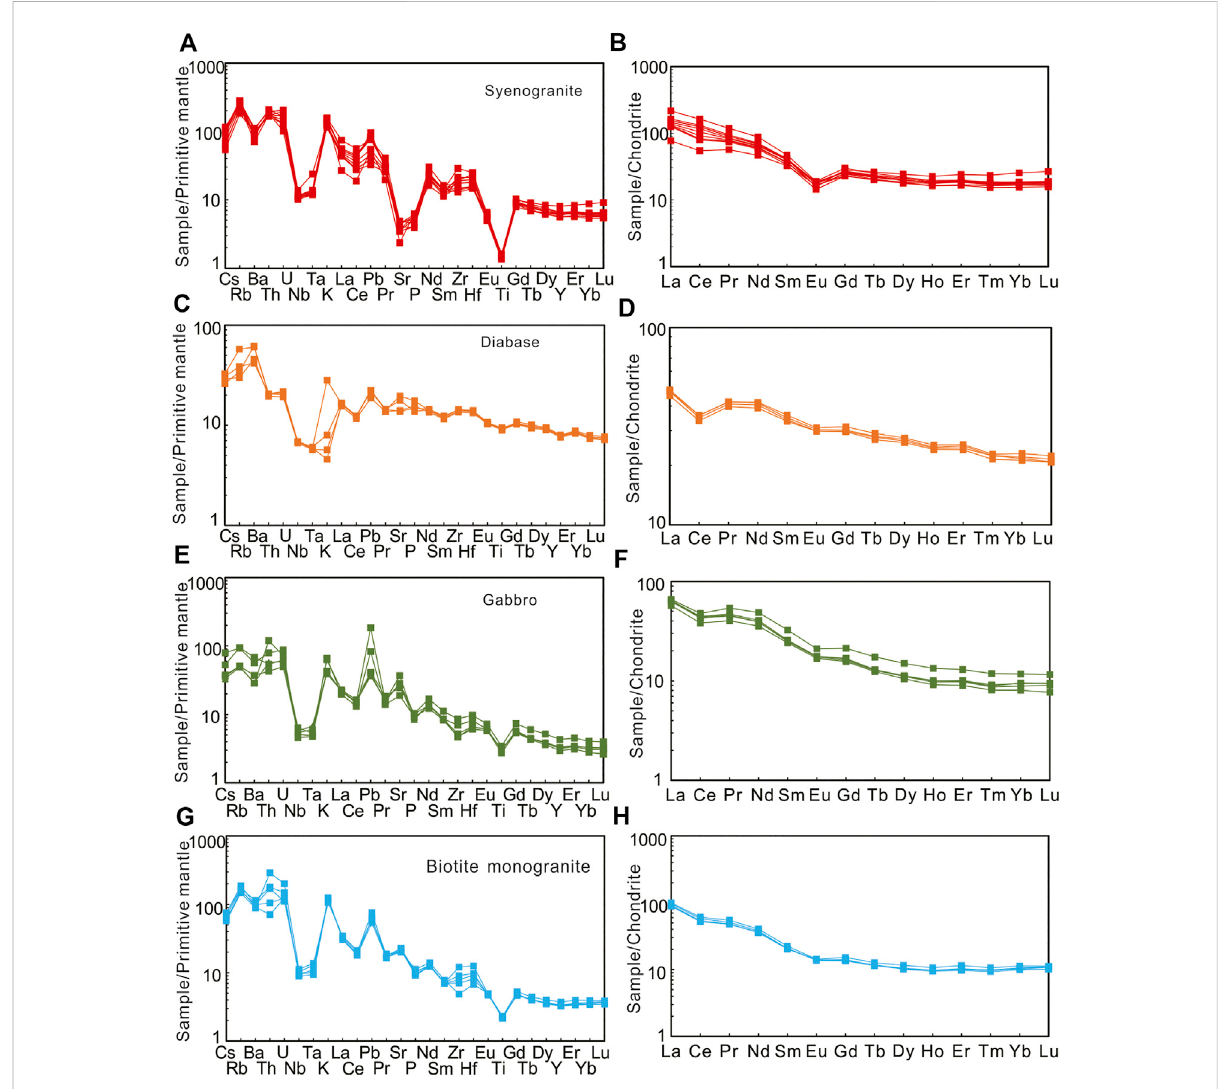
FIGURE 7 Primitivemantlenormalizedmulti-element (A – G) andchondritenormalizedREEpatternsdiagrams (B – H) ofthesyenogranitesandthediabase, gabbro and biotite monzogranite. Data for chondrite and primitive are from Sun & McDonough (1989).